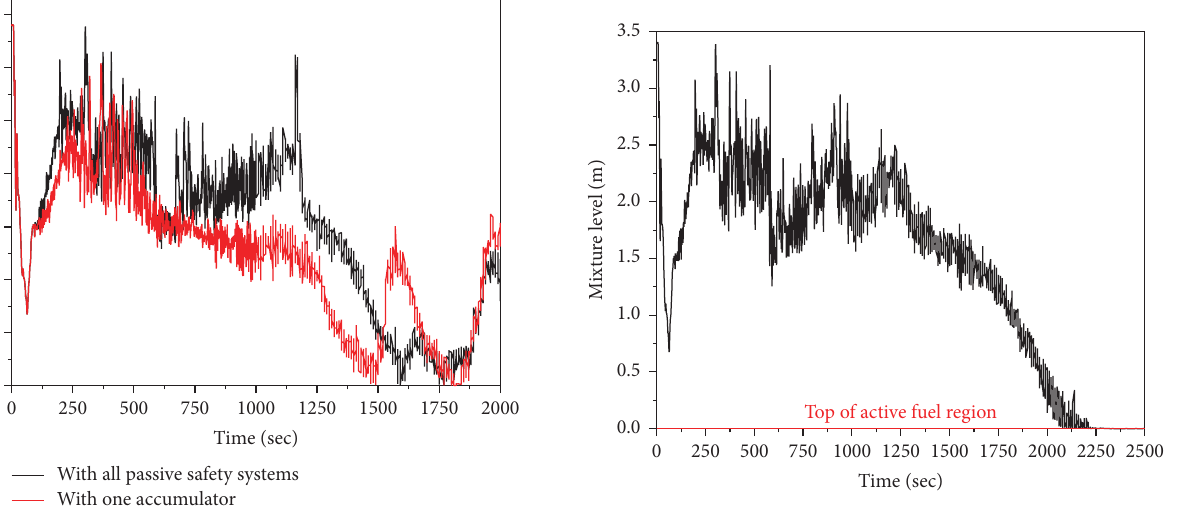
Figure 11: Comparison of mixture level above core active fuel region in case-1 and case-2.